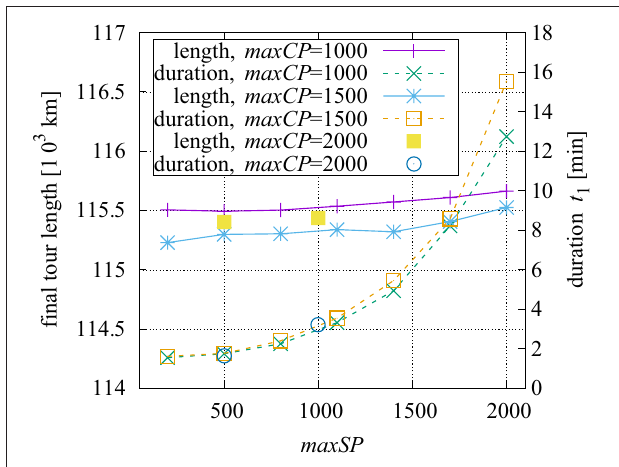
FIGURE 7 | Final tour length after 60 min depending on parameters used for initial tour generation and fixed parameters for final optimization ( N 1 with lenMax 6, N 2 300). = =